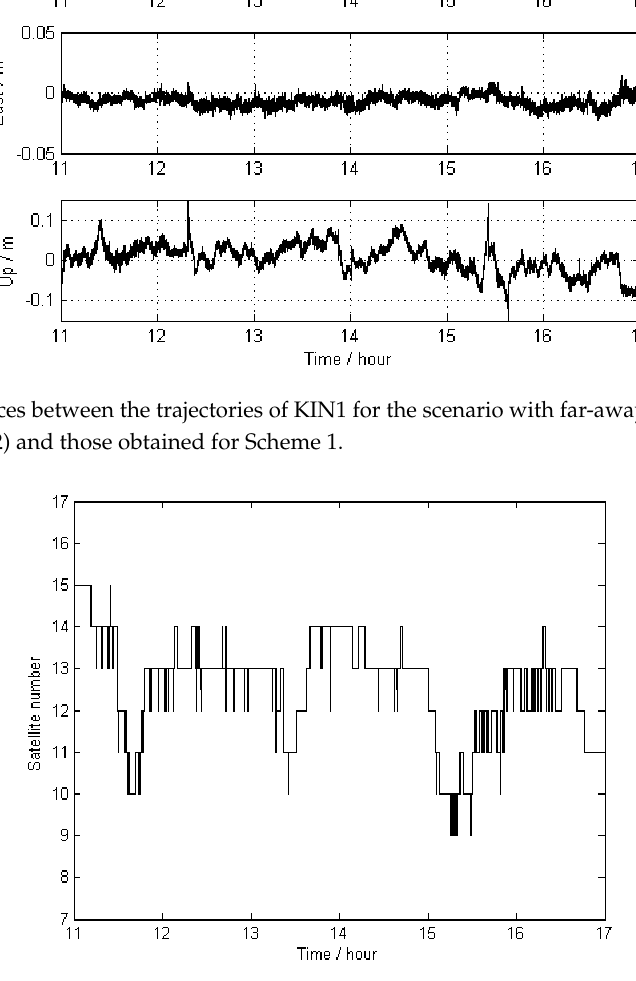
Figure 7. Total number of the visible satellites (GPS + GLONASS) during the measurement time span